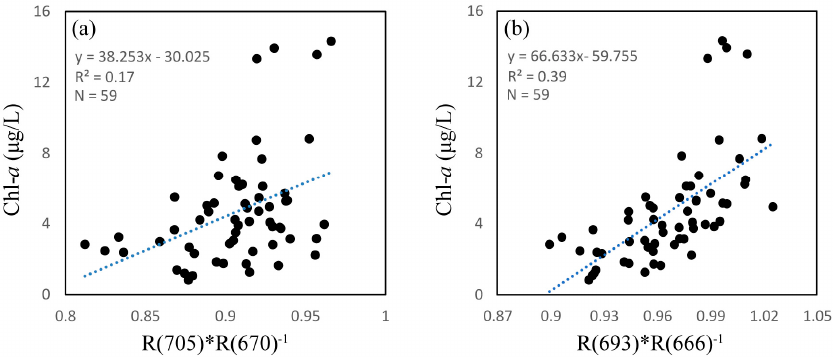
Figure 5. Relationship between observed chlorophyll a (Chl- a ) concentration and near-infrared/red reflectance ratio, ( a ) Ratio of R(705) to R(670); ( b ) Ratio of R(693) to R(666).